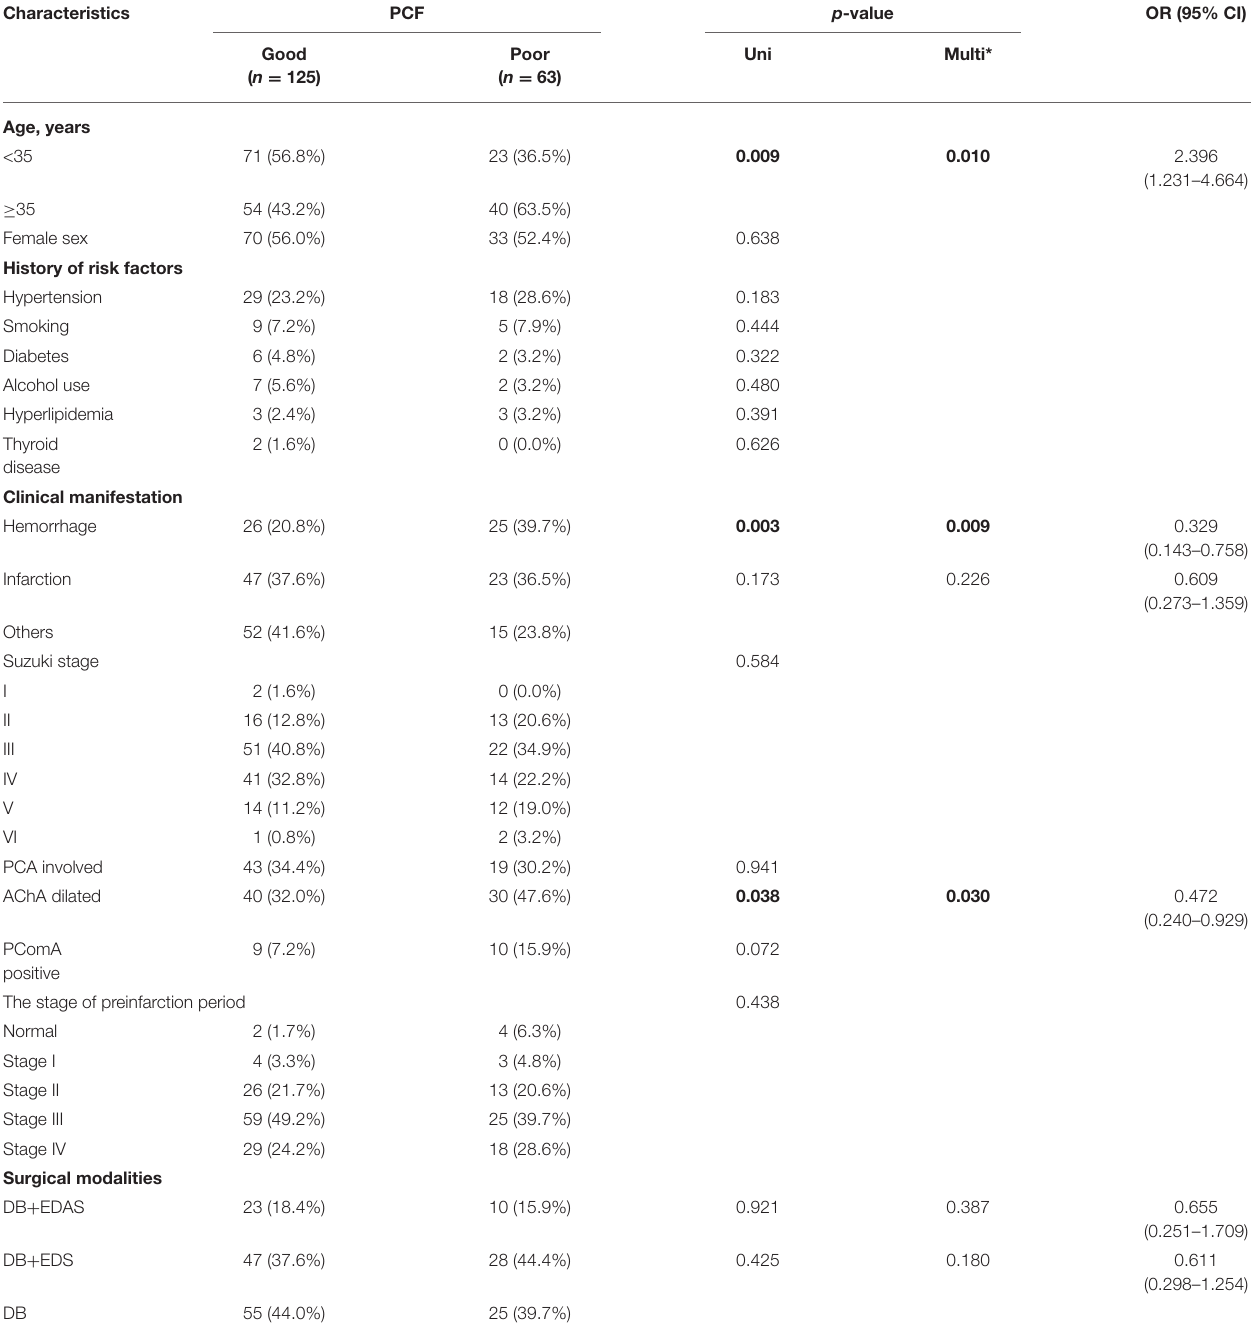
TABLE 4 | Logistic regression analysis of predictors for postoperative collateral formation.